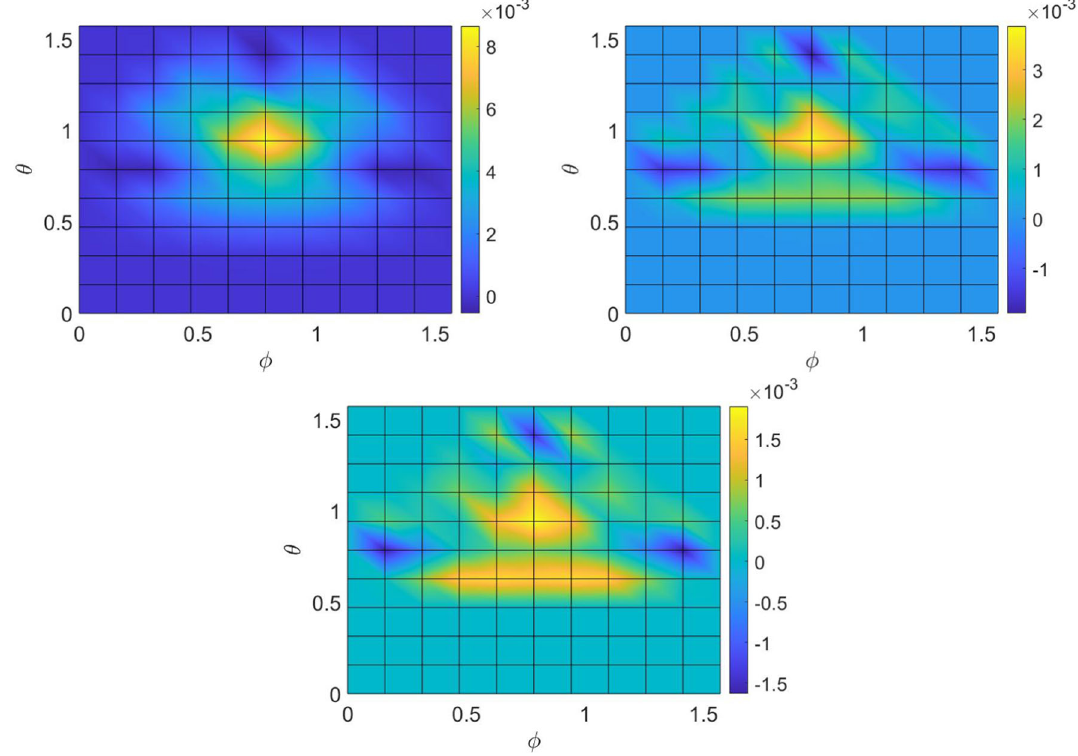
Fig. 9 The cumulant ac 2 for N = m = 3 N c = 3 when k r = 2 , 4 , 6 GeV and B = 4 GeV −